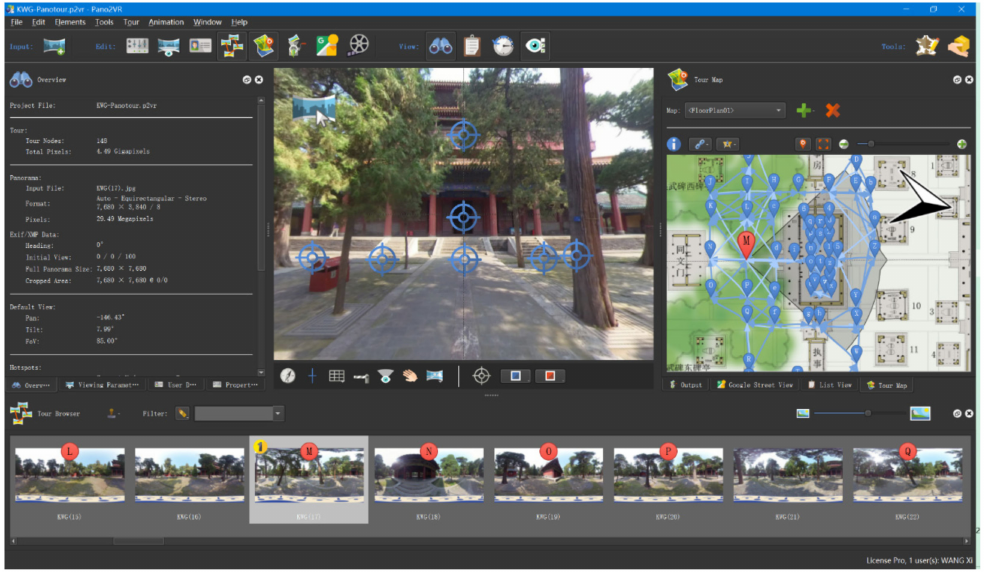
Figure 9. The virtual tour with 149 nodes generated in